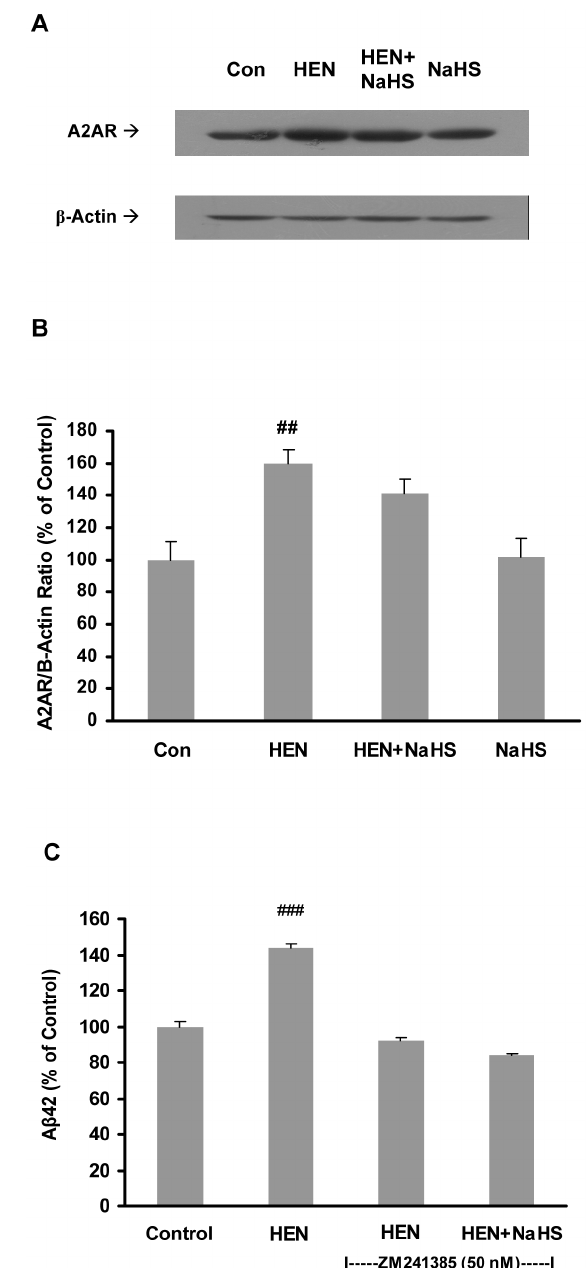
Figure 4. Effect of NaHS on A b 42 production involved PKA and CREB. A : Effect of HENECA (100 nM) on A b 42 formation was abolished by a PKA inhibitor, H89 (5, 10 and 15 m M). B–C : Representative gel (B) and histogram (C) depicting that pretreatment with NaHS (100 m M, 12 hours) attenuated the effects of HENECA (100 nM, 24 hours) on phosphorylation of CREB. Control values were adjusted to 100%. Data are given as means 6 S.E.M, n=4–6. ### p , 0.001 vs Con group; * p , 0.05, ** p , 0.01, *** p , 0.001 vs HEN group. Con, control; HEN, HENECA.